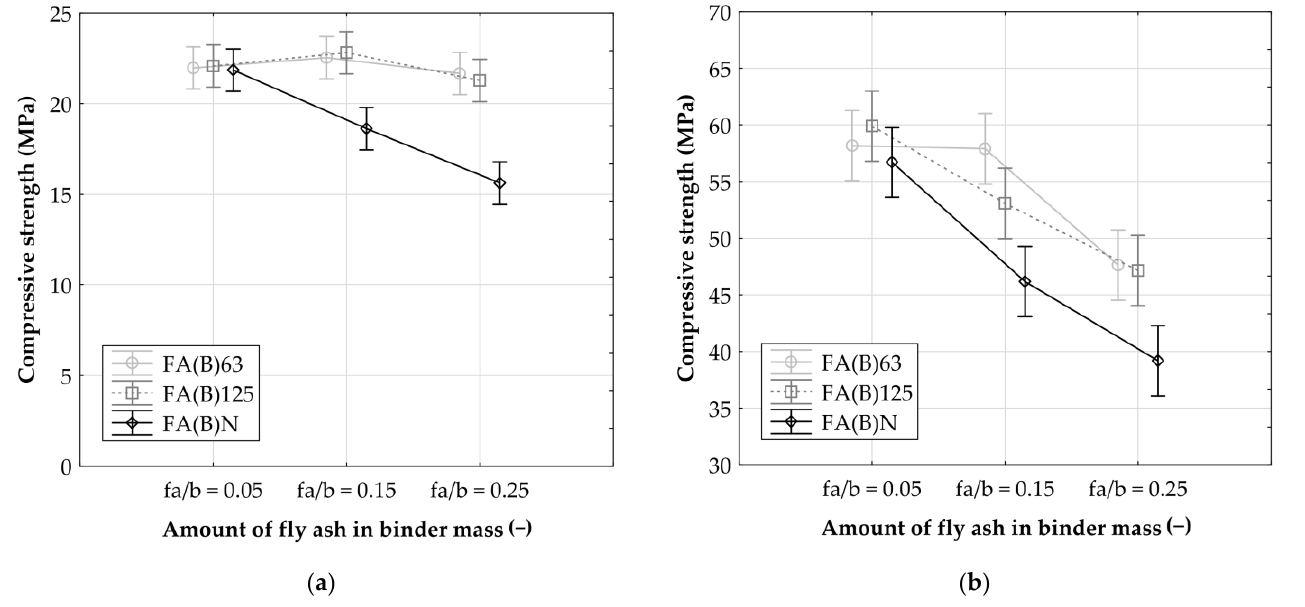
Figure 7. The ( a ) 2-day and ( b ) 90-day compressive strength test results of mortars with the addition of sieved fly ash (FA(B)63 or FA(B)125) compared with the results of mortars with untreated fly ash (FA(B)N) (ANOVA 95% CI in the whiskers).